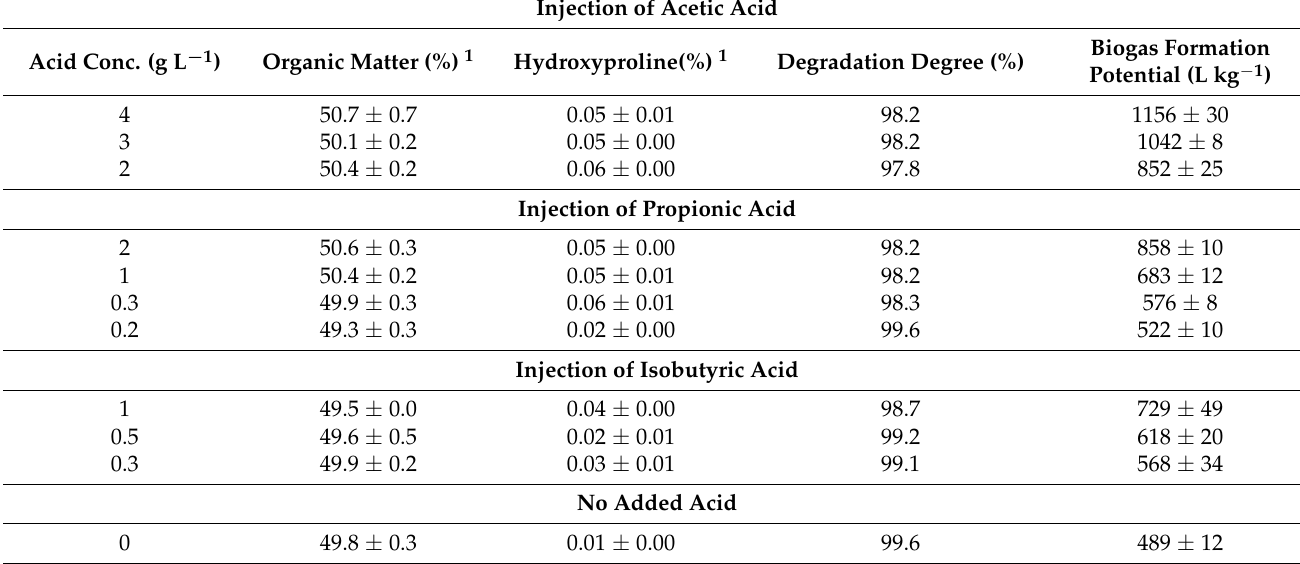
Table 5. Characterization of the final biomass, degradation degree of hydroxyproline, and biogas formation potential for bioreactors investigating